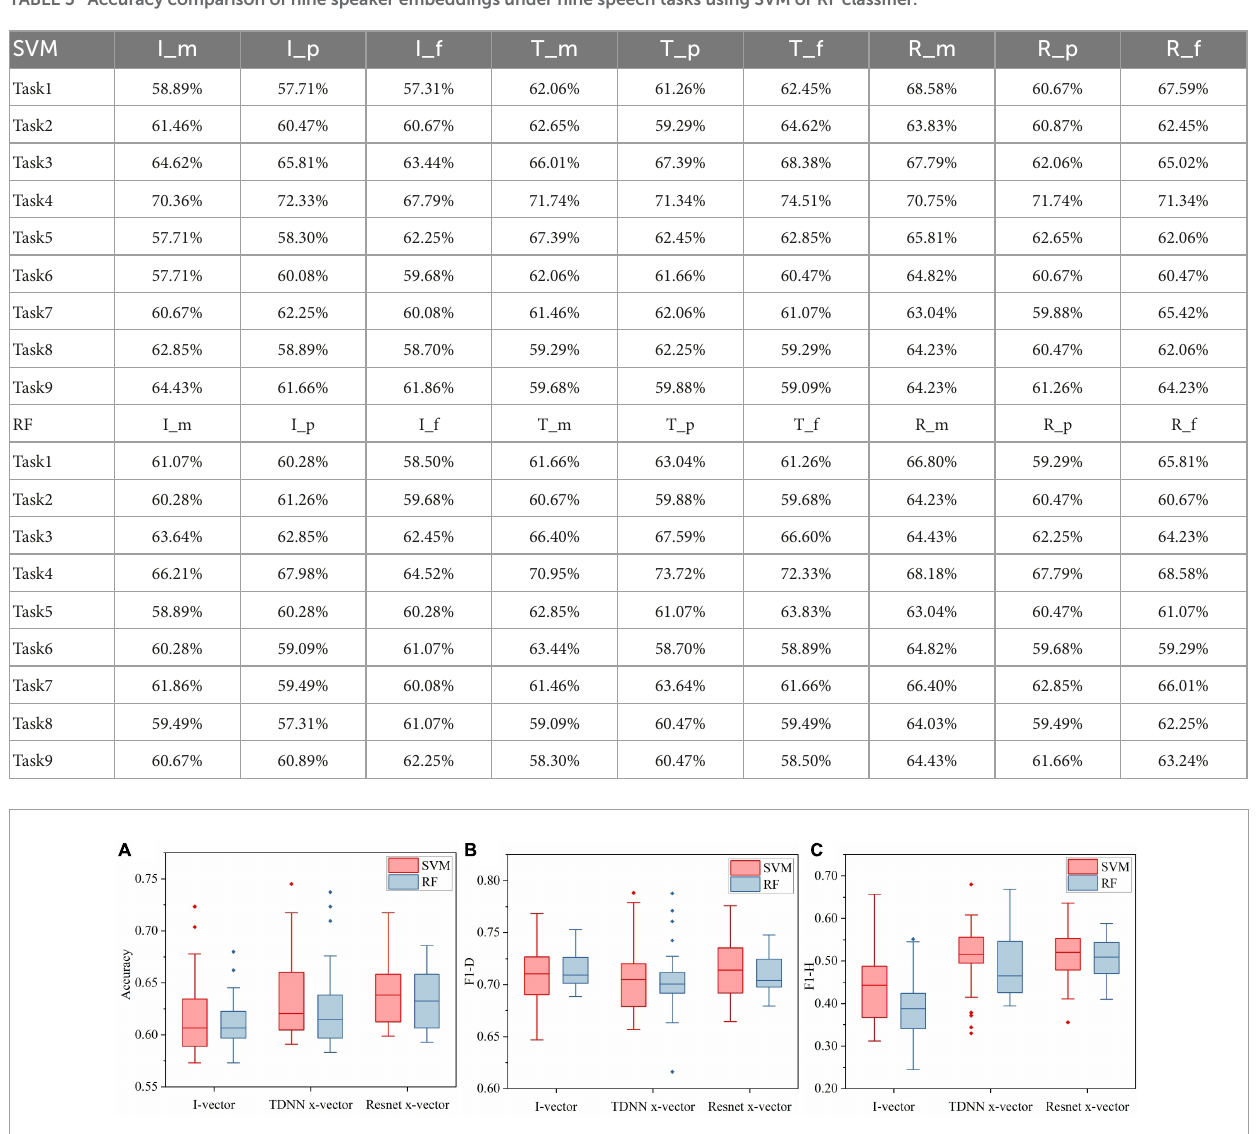
FIGURE4 The result comparison of speaker embeddings based on three extractors in nine speech tasks between SVM and RF. (A) Accuracy boxplot. (B) F1-D boxplot. (C) F1-H